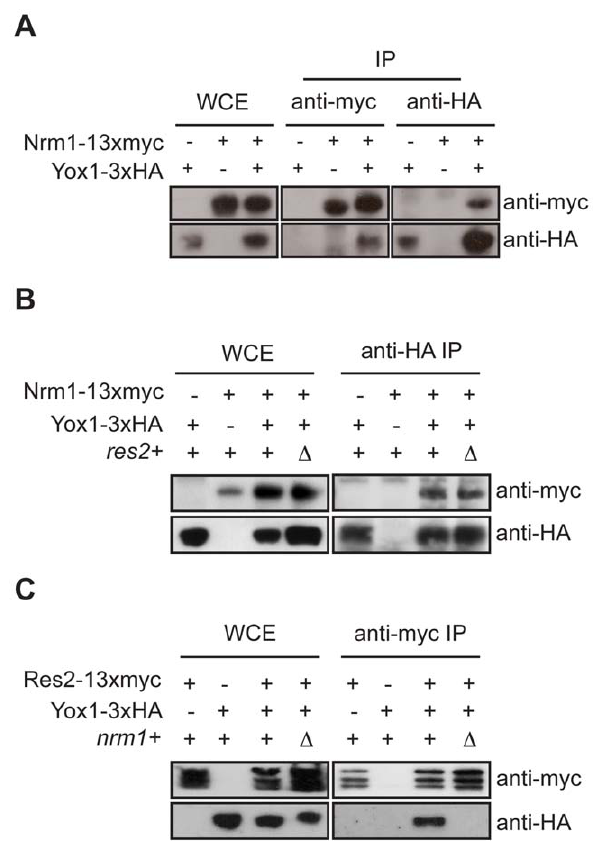
Figure 1. Yox1p interaction with MBF is Nrm1p-dependent. (A, B and C) Western blot analysis of anti-myc and anti-HA immune precipitates (IP) and whole cell extract (WCE), deriving from Nrm1- 13xmyc, Yox1-3xHA, Nrm1-13xmyc-Yox1-3xHA and Res2-13xmyc tagged cells, in the presence or absence of either nrm1 + or res2 + . Tagged proteins were detected by anti-HA and anti-myc